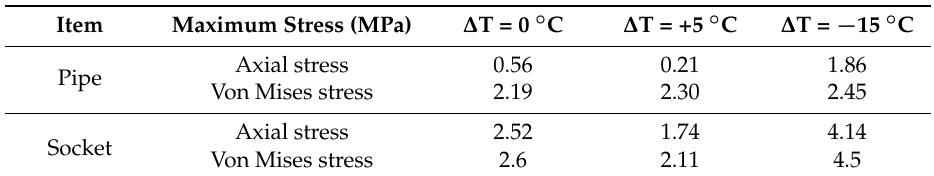
Table 2. The simultaneous effect of soil column pressure, pipe internal pressure, vehicle wheel load, and temperature variations.